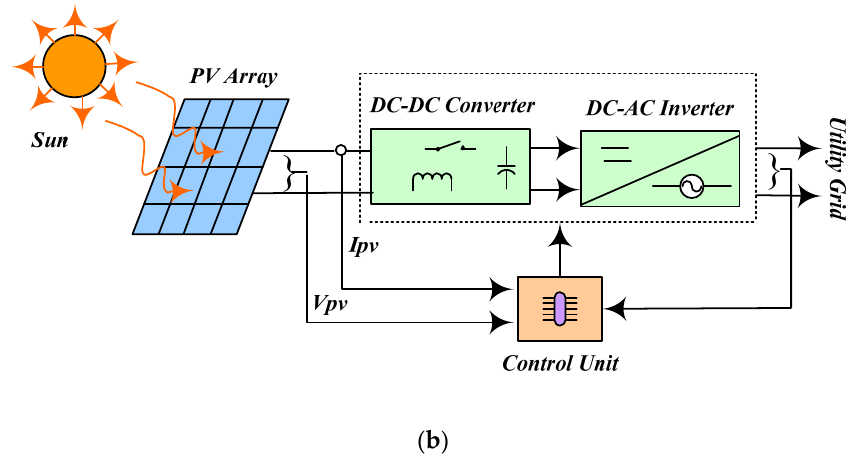
Figure 1. Generalized block diagram of ( a ) standalone PV system and ( b ) grid-connected PV system.